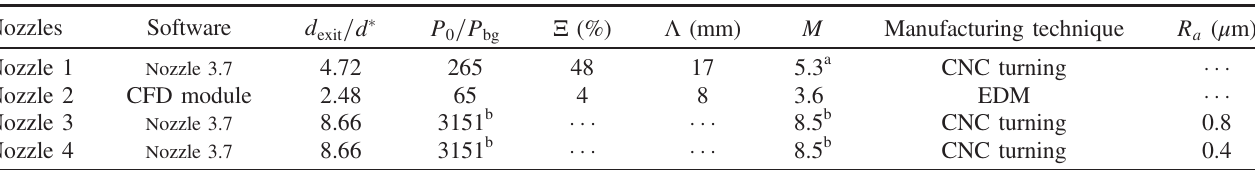
=P as calculated using Eq. (14). 0 bg